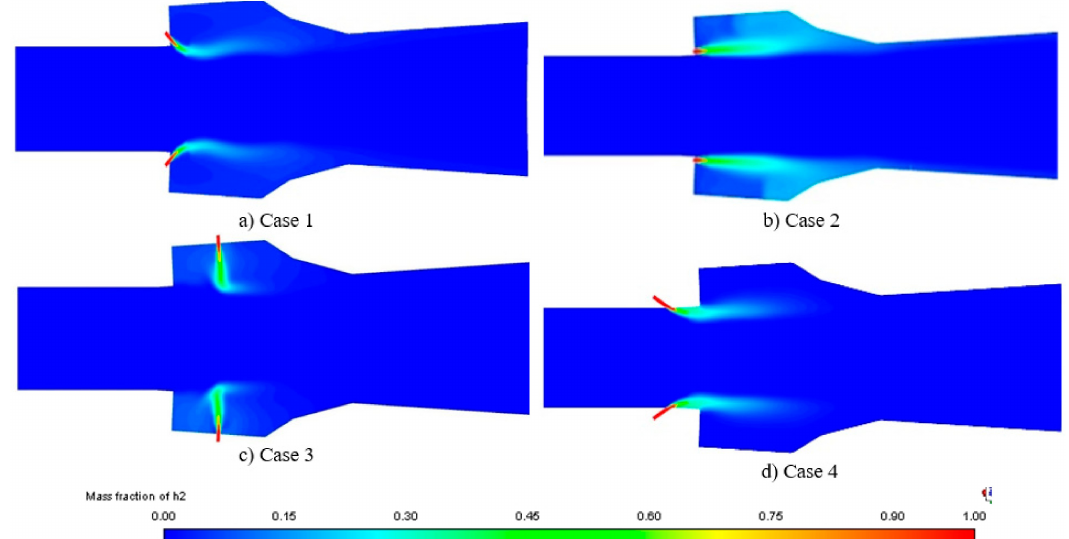
Figure 8. Hydrogen mass fraction contour for the injection